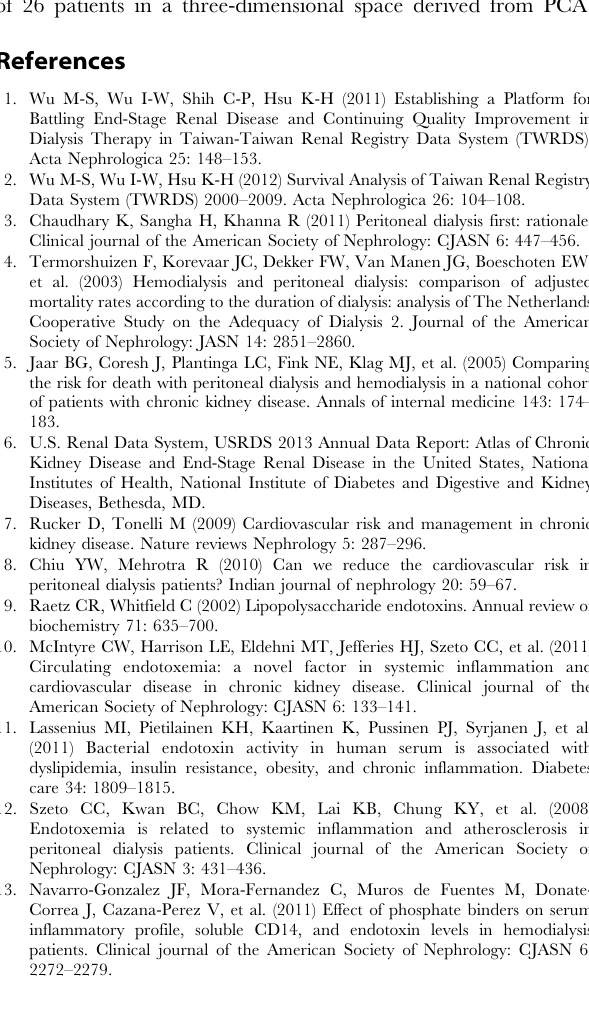
The scores plot shows grouping of the demographic and laboratory profiles between short (blue open circle) and long (green open triangle) PD duration groups. (TIF) Figure S2 Correlations between the duration of PD and biological (a–f) and dialysis-related (g–i) parameters in patients on CAPD. Duration of PD was not correlated with serum albumin (a), cholesterol (b), triglyceride (c), low-density lipoprotein cholesterol (d), high-density lipoprotein cholesterol (e), uric acid (f), normalized protein nitrogen appearance (g), or total weekly creatinine clearance (h). (TIF) Figure S3 Correlations between the duration of PD and various serum cytokine levels except MCP-1 in patients on CAPD. Duration of PD was not correlated with plasma interleukin-1 b (a), interleukin-1 receptor antagonist (b), interleu- kin-6 (c), interleukin-8 (d), interleukin-10 (e), interleukin-12p70 (f), tumor necrosis factor (g), granulocyte-macrophage colony-stimu- lating factor (h), or interferon- c (i) levels.